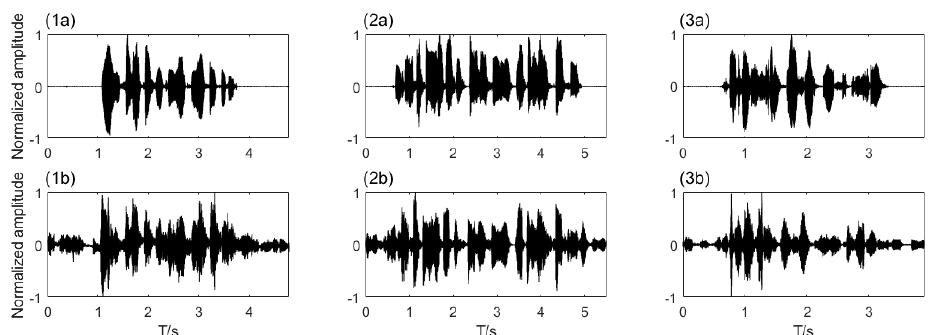
Figure 15. Original signals ( a ) and the reconstructed signals ( b ) in the experimental study: ( 1 ) s 1 , ( 2 ) s 2 , and ( 3 ) s 3 .